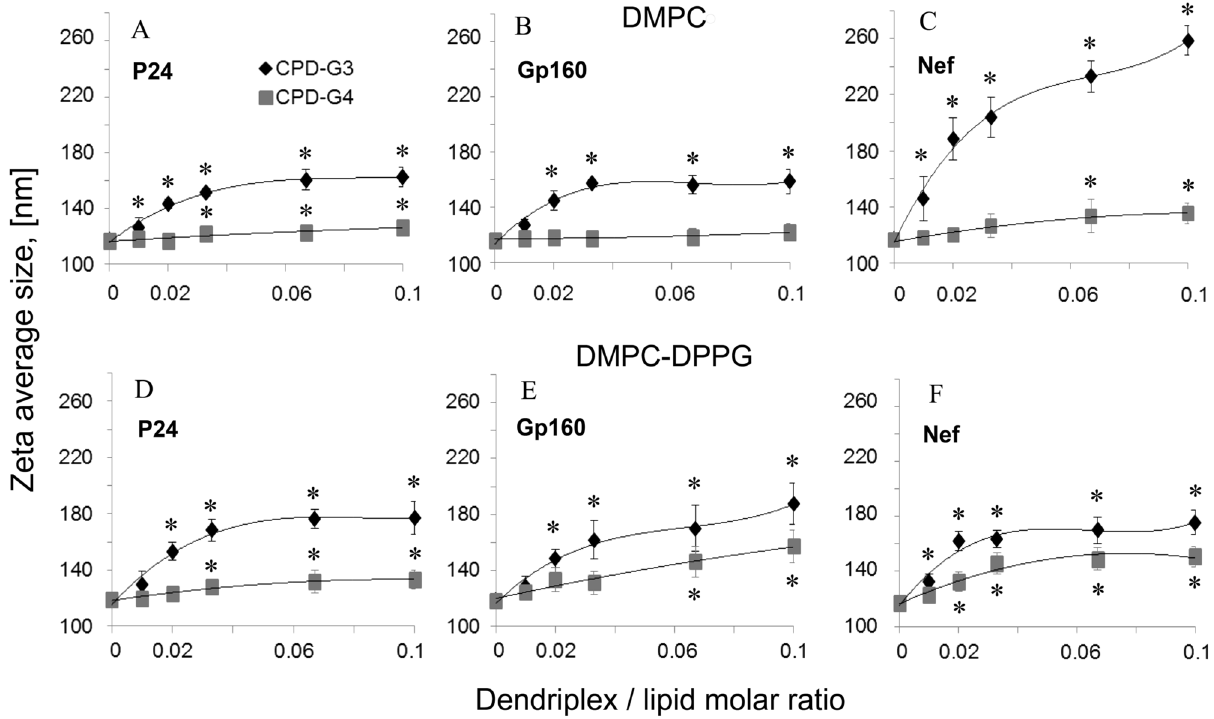
Figure 2. Average size of liposomes upon addition of cationic phosphorus dendrimers/HIV peptide complexes for each combination of peptides and dendrimers ( CPD-G3 or CPD-G4 ): ( A ) DMPC + P24 + Dendrimers; ( B ) DMPC + Gp160 + Dendrimers; ( C ) DMPC + Nef + Dendrimers; ( D ) DMPC–DPPG + P24 + Dendrimers; ( E ) DMPC–DPPG + Gp160 + Dendrimers; ( F ) DMPC–DPPG + Nef + Dendrimers. Results are mean ± S.D., n = 6. *Statistically significant differences in comparison to the control (liposomes) (* p < 0.05), and statistically significant differences between dendrimers (CPD-G3 and CPD-G4) for all points for DMPC + Nef + D and from molar ratio 0.02 for all other